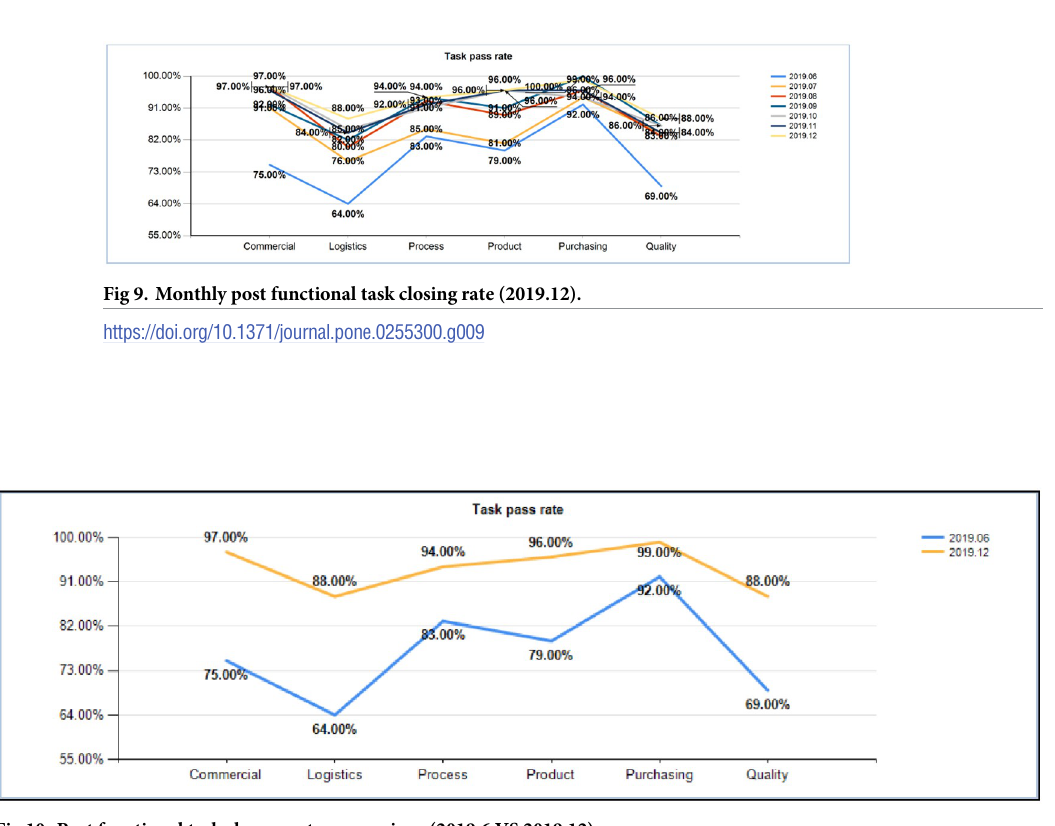
Fig 10. Post functional task closure rate comparison (2019.6 VS 2019.12).